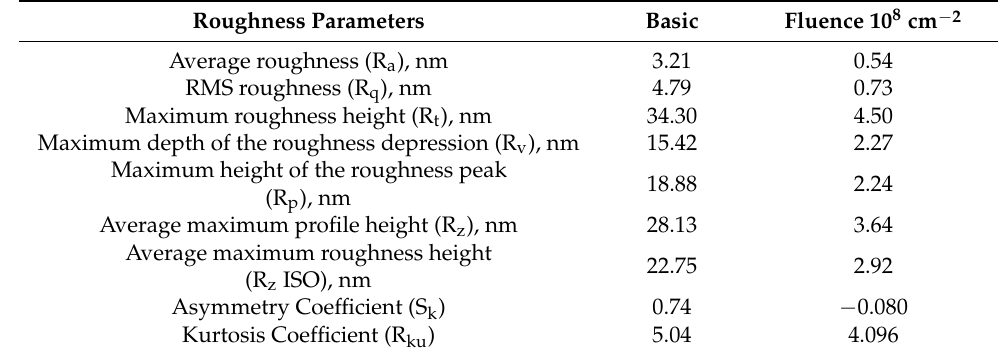
Table 3. Comparison of the surface roughness parameters of the initial and irradiated xenon ions with an energy of 1 MeV/nucleon to a fluence of 10 8 cm − 2 thermoradiationally modified polytetrafluoroethylene. Roughness Parameters